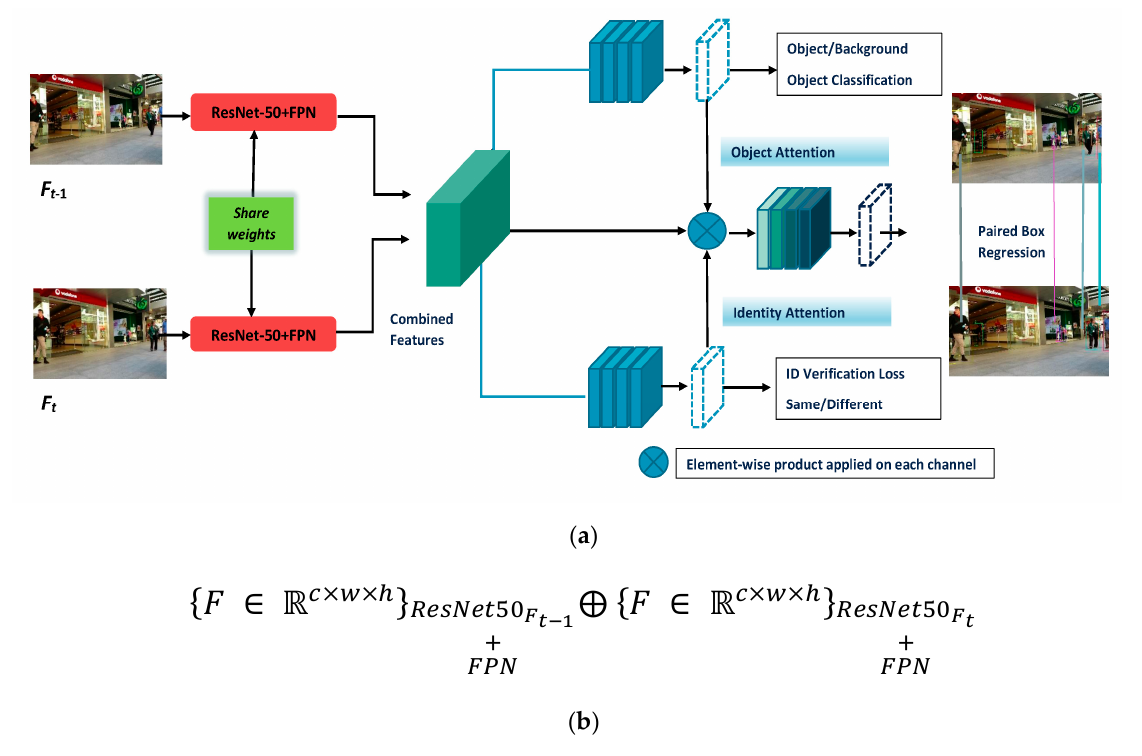
Figure 2. Feature extraction frame-wise with two adjacent frames using two backbone branches consisting of ResNet-50 with FPN by parametric sharing for classification and regression branches, ( a ) SCT architecture, and ( b ) operation expression for combined features.